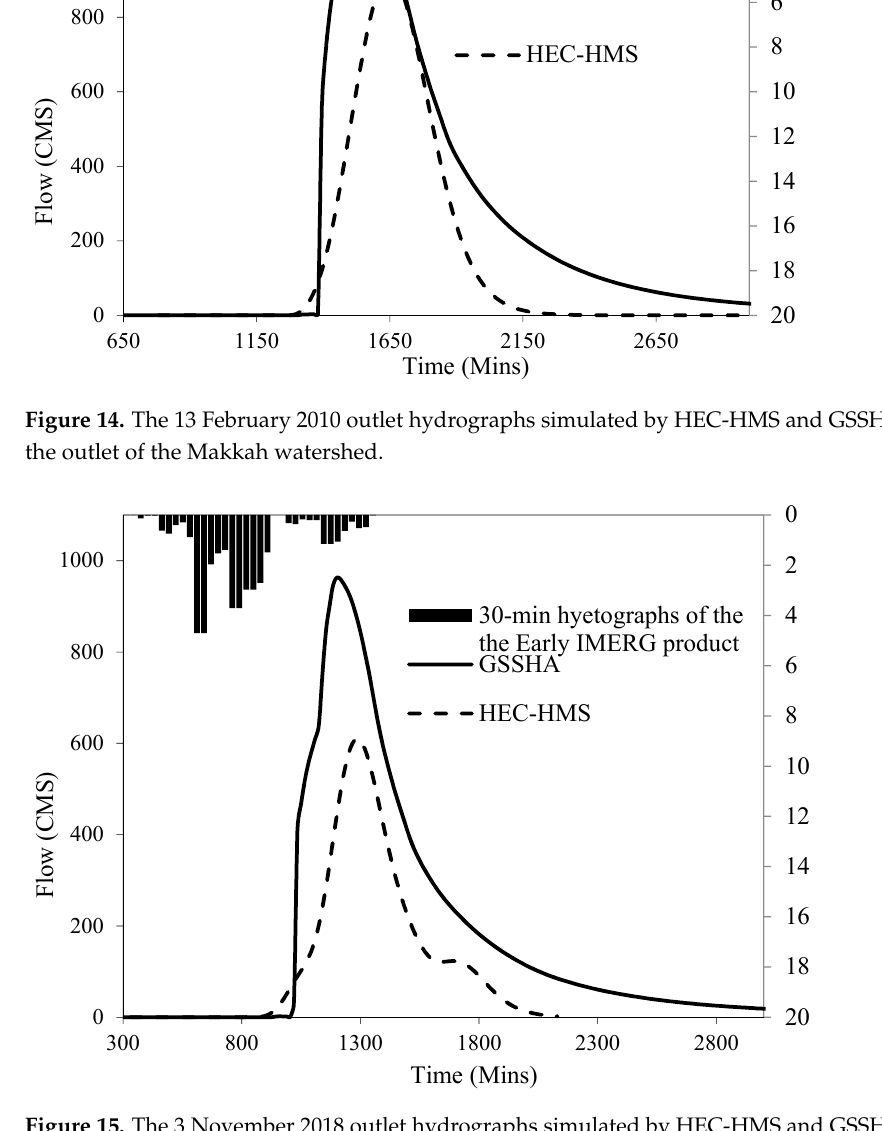
Figure 15. The 3 November 2018 outlet hydrographs simulated by HEC-HMS and GSSHA models at the outlet of the Makkah watershed.